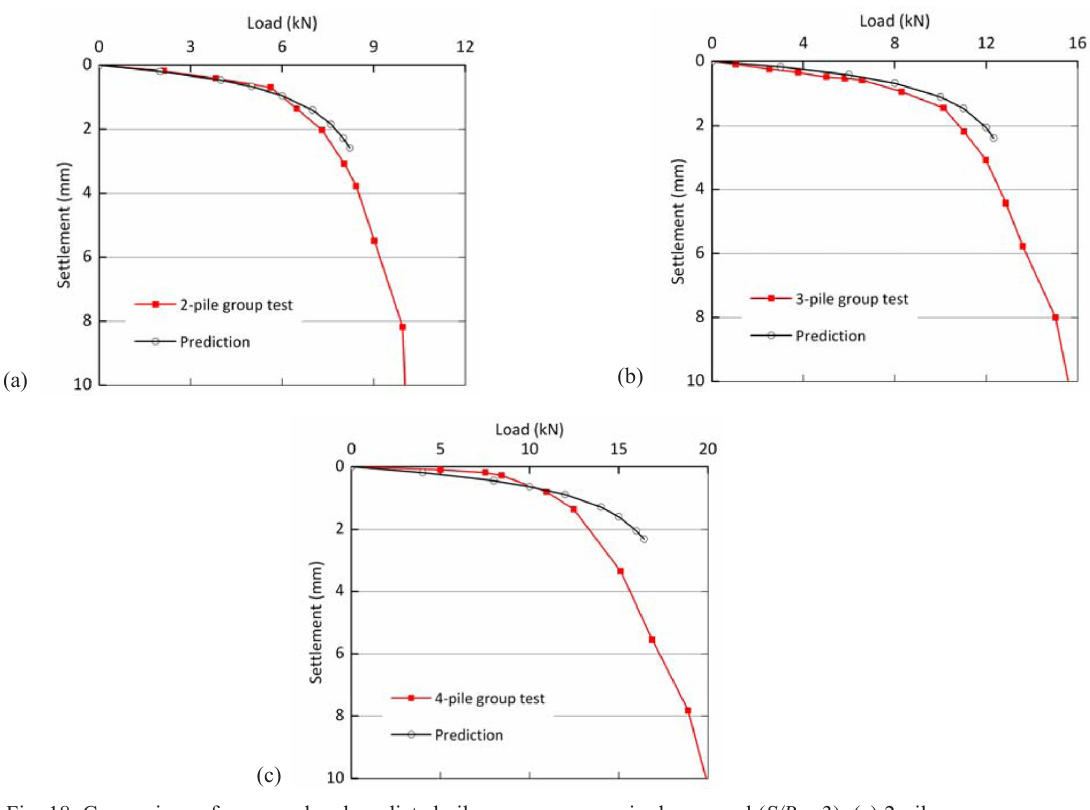
Fig. 18. Comparison of measured and predicted pile group response in dense sand ( S/B = 3): (a) 2-pile group;